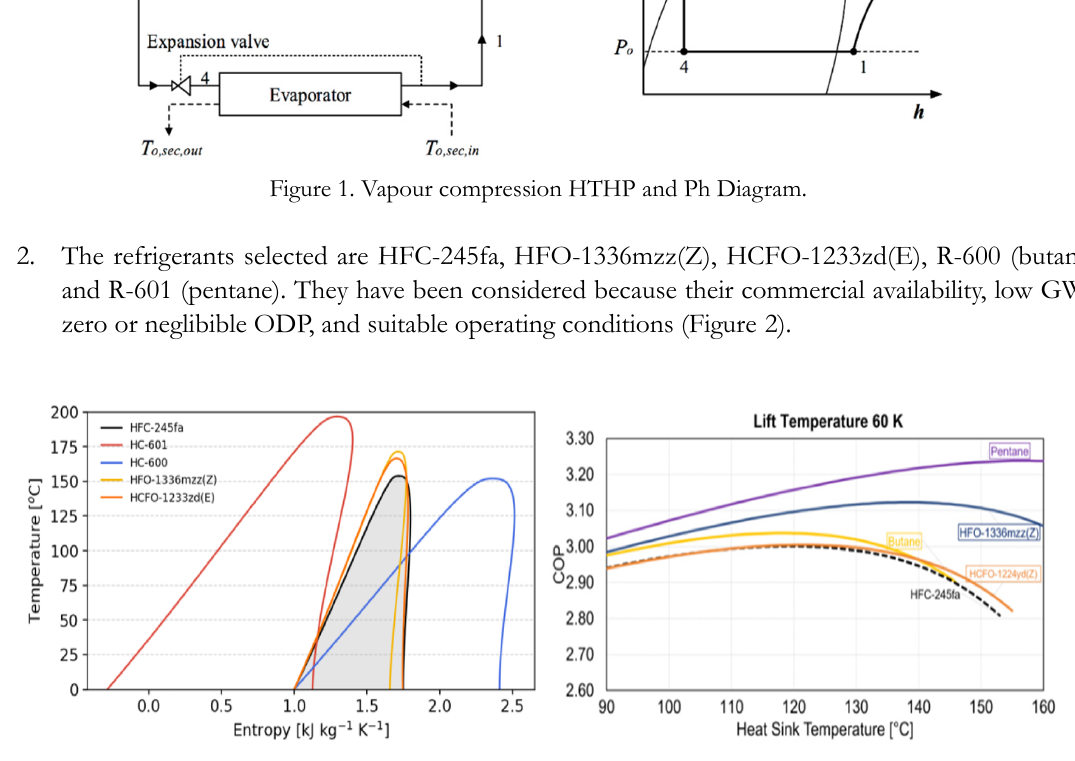
Figure 2. Ts diagram and COP at different heat sink temperatures for the selected